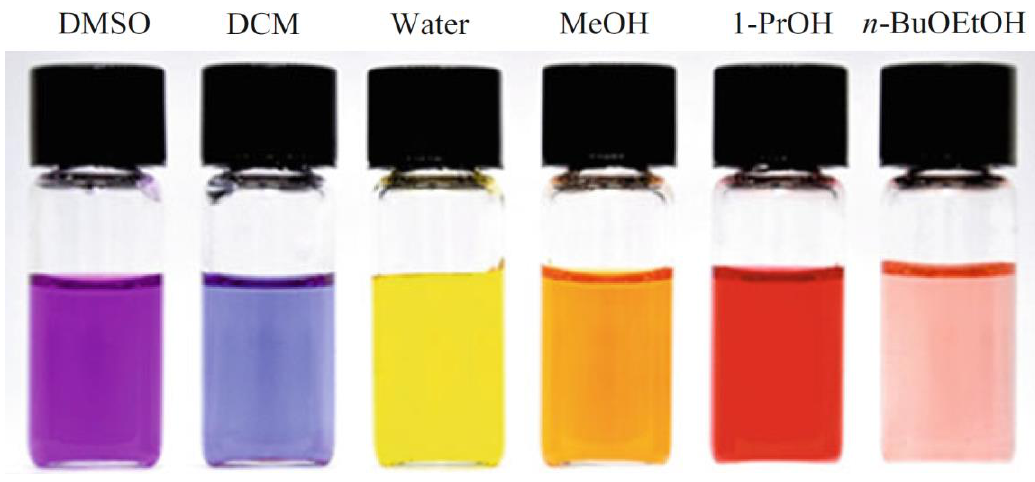
Figure 5. Colors of the solvatochromic polarity indicator 2,6-Dibromo-4-(E)-2-1(1- methylpyridinium-4-yl)ethenyl]phenolate in different solvents; DCM refers to dichloromethane; reproduced from [17], with permission from Springer,2018.